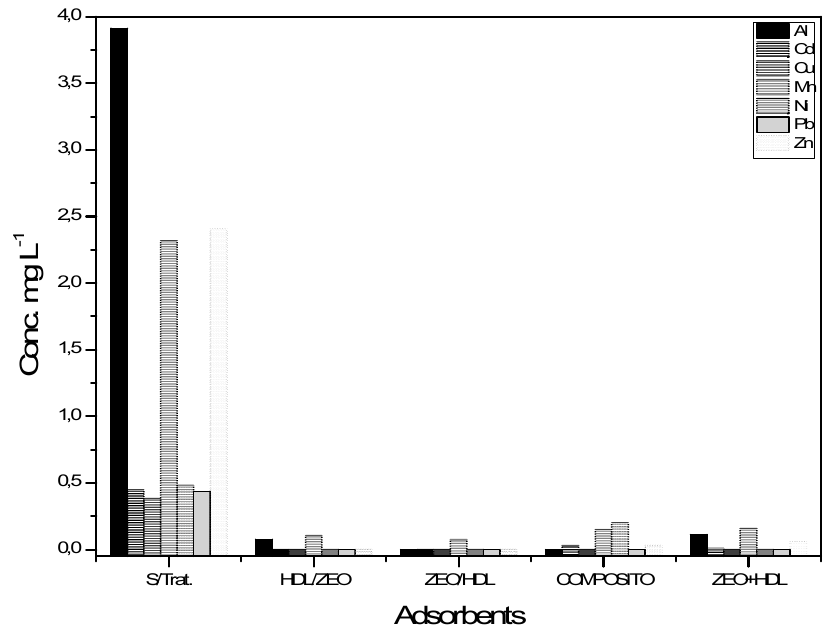
Figure 5. Variations of the concentrations of Al, Cd, Cu, Mn, Ni, Pb and Zn ions in water produced